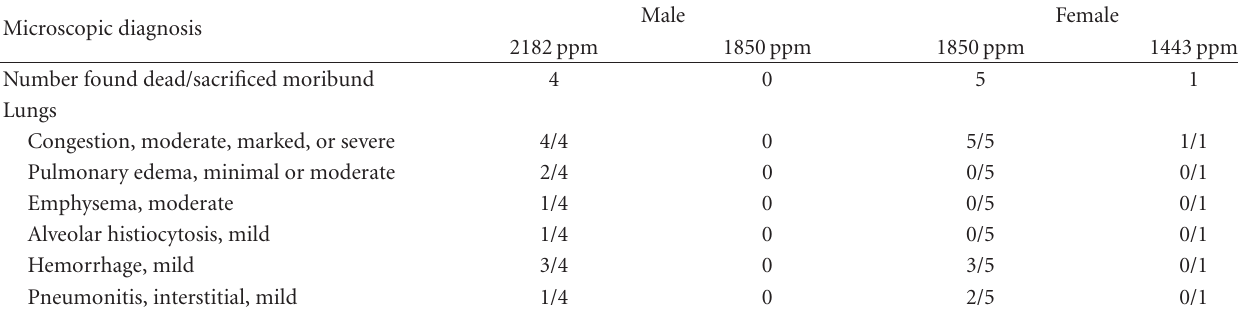
Table 5: Lung histopathology of animals that died following 4-hour exposures to EO.